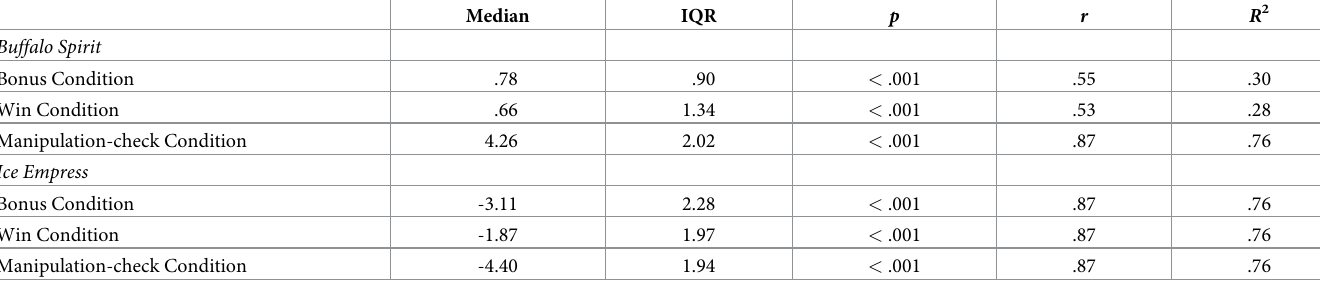
Table 4. Difference score medians, IQRs, Wilcoxon signed-rank test p-values and effect sizes.